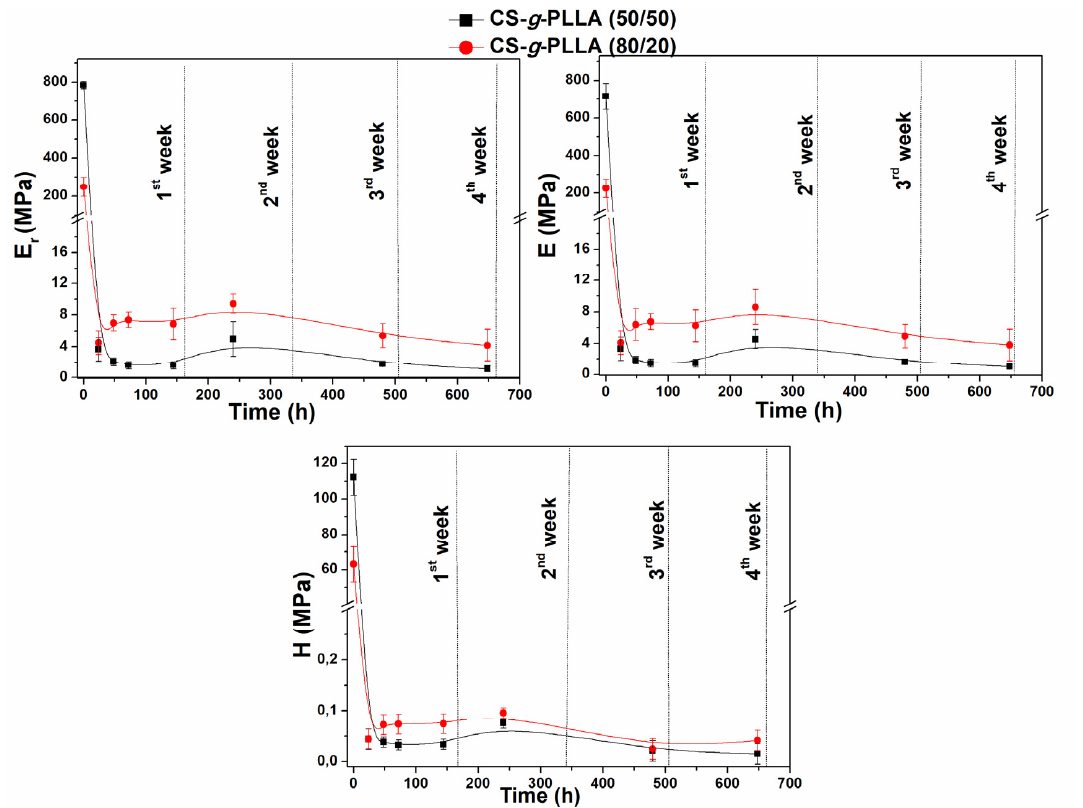
Figure 6. Reduced modulus (Er), Young’s modulus (E) and hardness (H) values for the CS- g -PLLA copolymers at 500 µ N as a function of immersion time in α -MEM medium. Table 3. Reduced modulus (Er), Young’s modulus (E) and hardness (H) values at 500 nm indentation depth following immersion in α -MEM for different time periods.